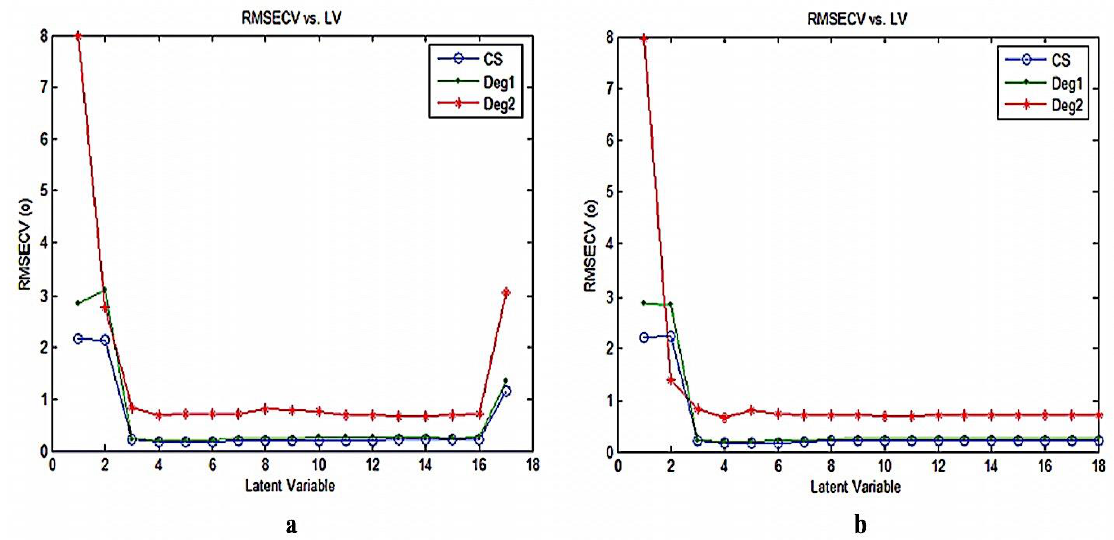
Figure 4. Root mean squares of error of calibration (RMSEC) plot of the cross validation results of the training set as a function of the number of principle components used to construct ( a ) the PCR and ( b ) PLS-2 calibration using zero order spectra of CS, Deg1 and Deg2.